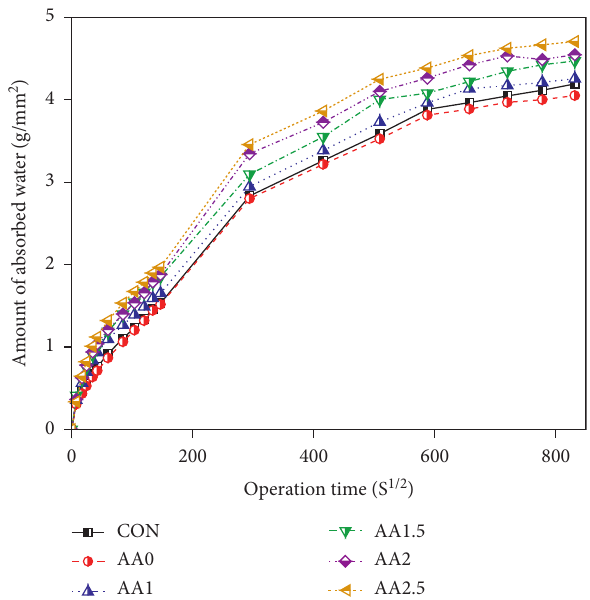
Figure 8: Capillary water absorption curve of the specimen.